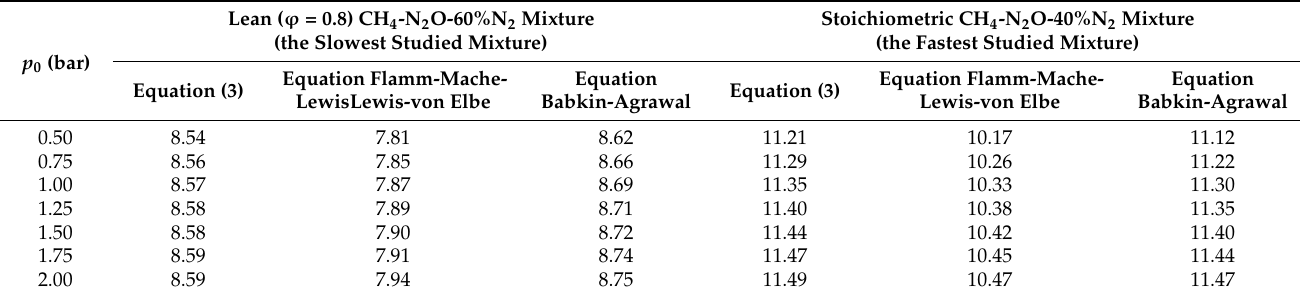
Table 3. Expansion coefficients of CH 4 -N 2 O mixtures diluted with N